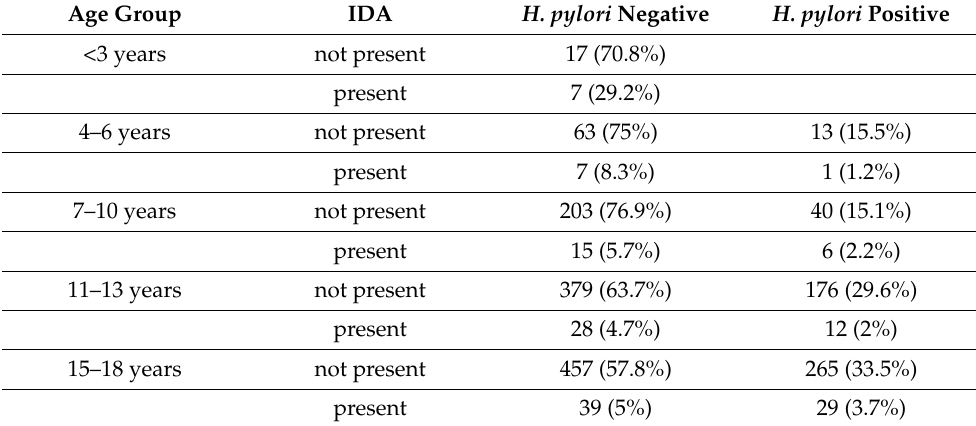
Table 2. H. pylori infection and anemia within various age groups.